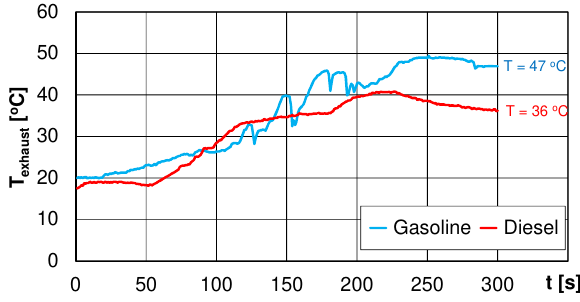
Fig. 9. The exhaust temperature during the cold start phase of the gasoline and diesel engines